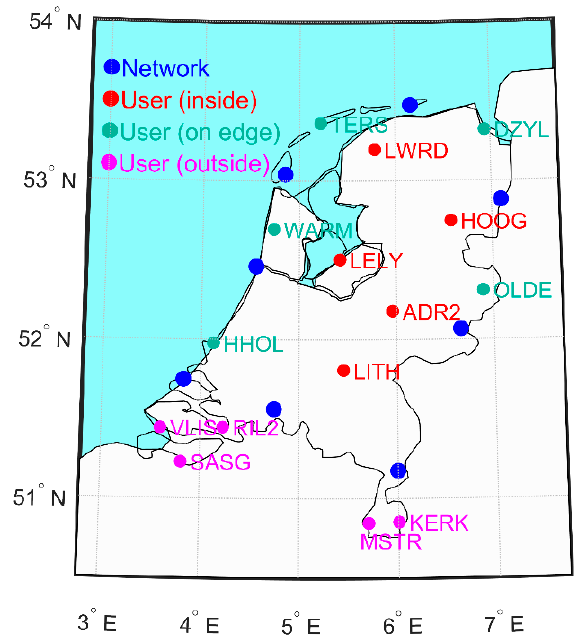
Figure 1. Sparse global navigation satellite system (GNSS) network with 8 reference stations and 15 user stations.